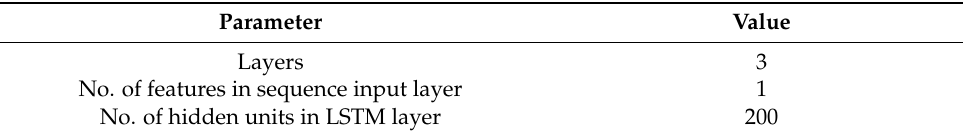
Table 1. Parameter setting of the LSTM